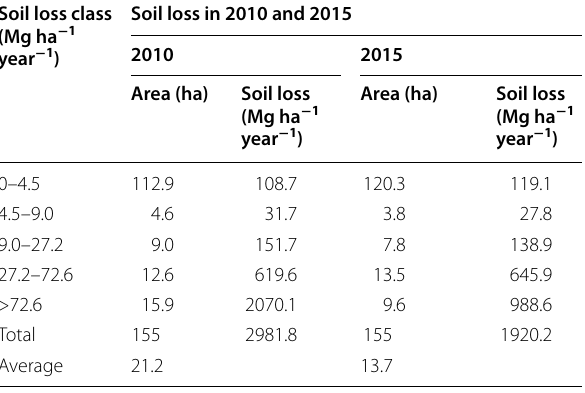
Table 7 Annual soil loss rate in 2010 and